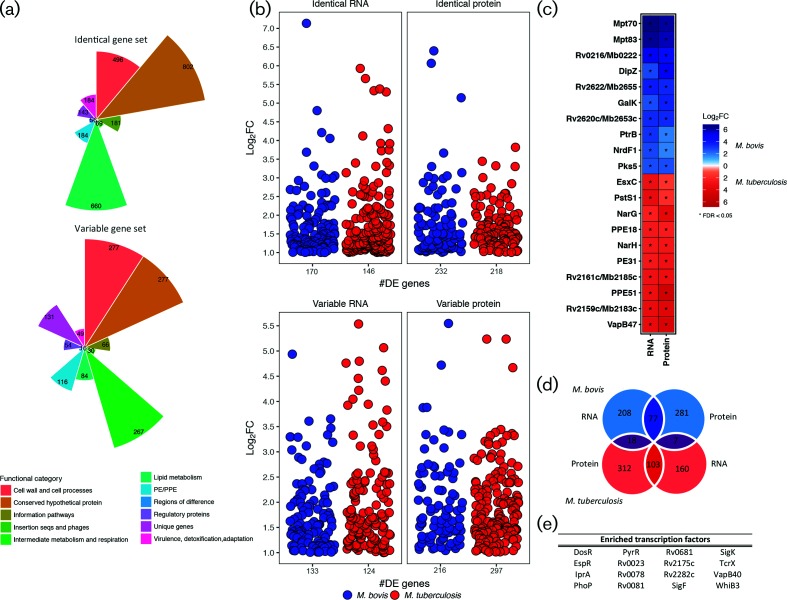
(a) The number of genes from M. bovis AF2122/97 and M. tuberculosis H37Rv classified as either ‘Identical’ (100 % conserved in length and amino acid sequence, top plot) or Variable (all other orthologous genes, bottom plot). Colours represent the various gene categories to which each gene belongs. (b) The level of expression (‘log2FC’) of Identical genes (top panel) and Variable genes (bottom panel) that are differentially expressed (|log2FC|>1, FDR<0.05) and upregulated in either M. bovis AF2122/97 (blue) or M. tuberculosis H37Rv (red) at both the RNA and the protein level. The number of genes in each category is indicated on the x-axis (‘#DE genes’). (c) The top 20 differentially expressed genes at the RNA and protein level [|log2FC|>1, FDR<0.05 (‘*’)] that are upregulated in M. bovis AF2122/97 (blue) or M. tuberculosis H37Rv (red). (d) The overlap of genes that are upregulated in either M. bovis AF2122/97 (blue) or M. tuberculosis H37Rv (red) at the RNA and protein level. Dark blue overlap represents those genes upregulated in M. bovis AF2122/97 only, dark red overlap represents those genes upregulated in M. tuberculosis H37Rv while purple overlaps represent those genes that show discordant expression patterns at the RNA and protein level between the two species. (e) The transcription factors enriched for ‘Identical’ genes (100 % conserved in length and amino acid sequence between the two species) that are differentially expressed between M. bovis AF2122/97 and M. tuberculosis H37Rv (Rand Index, P<0.01).